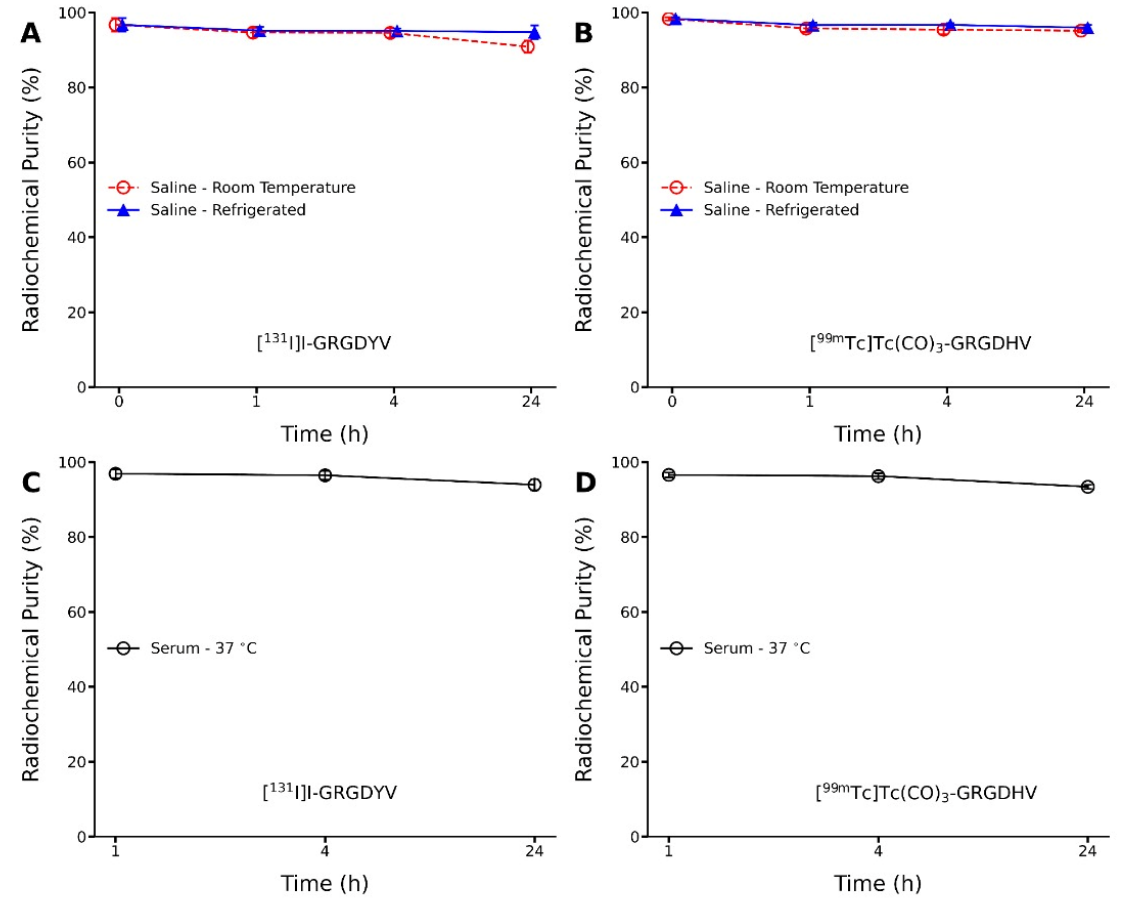
Figure 5. Stability of the radiopeptides up to 24 h ( A , B ) in saline solution and (C , D) in human serum. Data are expressed as ‘mean ± SD’. No significant differences were observed within time ( p > 0.05).